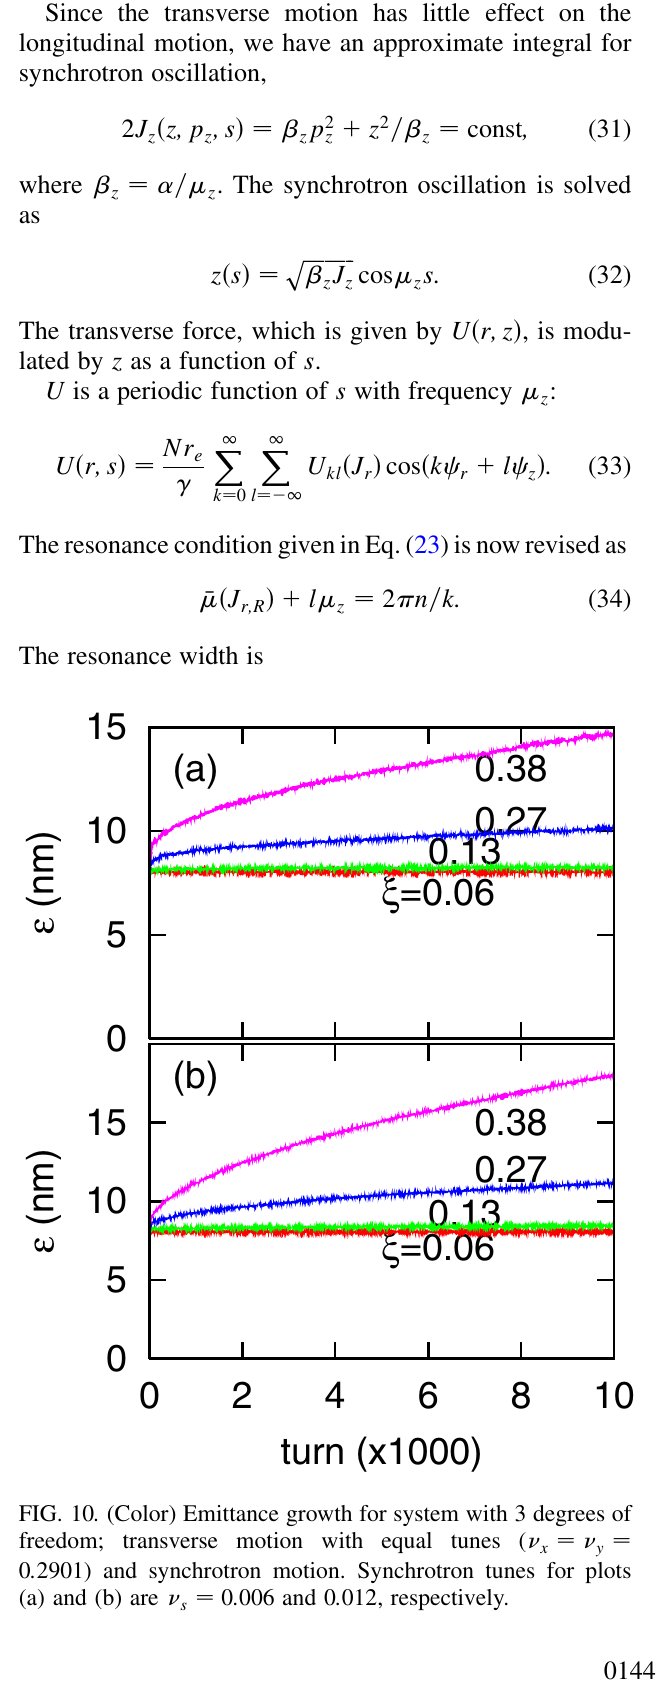
(cid:5) (cid:8) (cid:5) x y